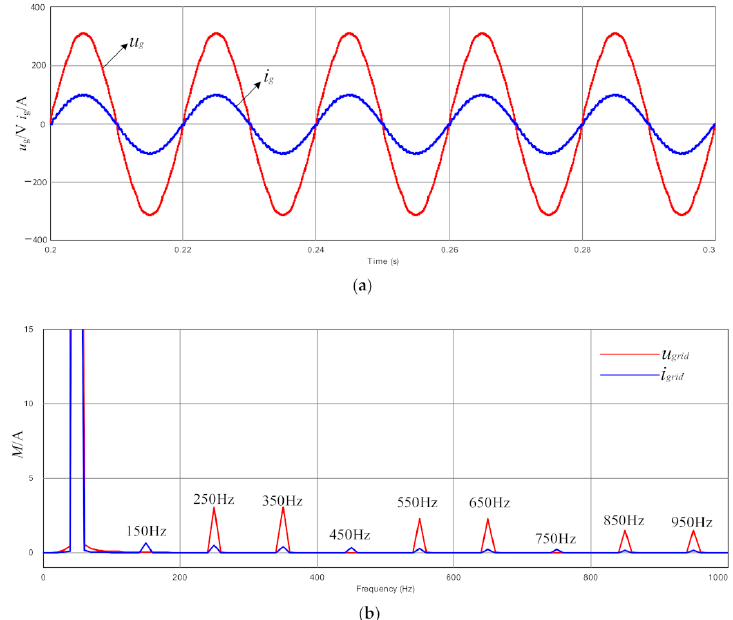
Figure 18. Waveforms of grid voltage and grid-tie current under a distorted power grid (combined harmonic suppression is used): ( a ) Time domain waveform of grid voltage and grid-tie current; ( b ) Spectrum of grid voltage and grid-tie